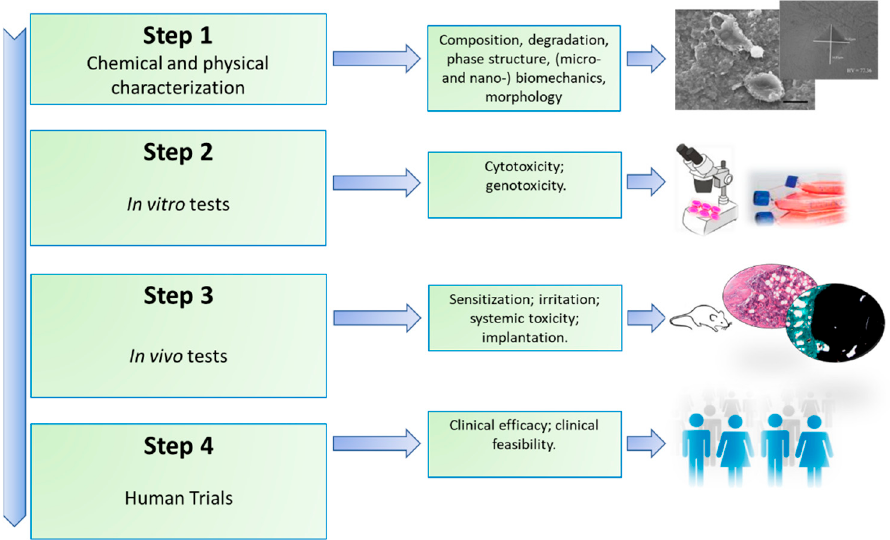
Figure 1. Main steps involved to establish the safety of a newly developed